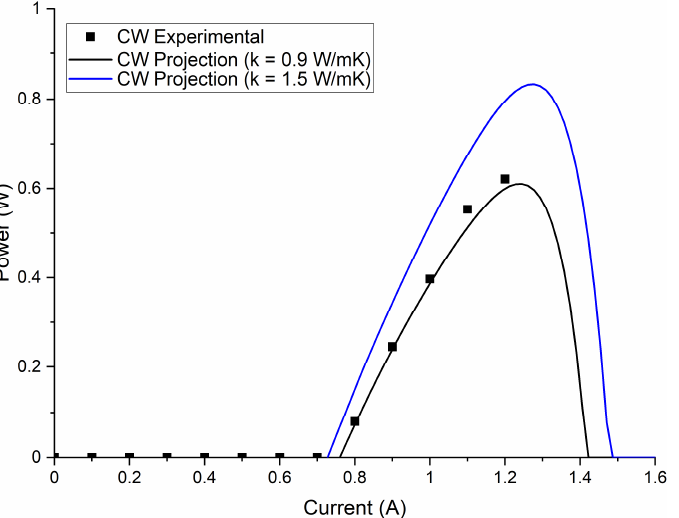
Figure 7. CW Power projection for the two extremes of thermal conductivity for the S25 structure.